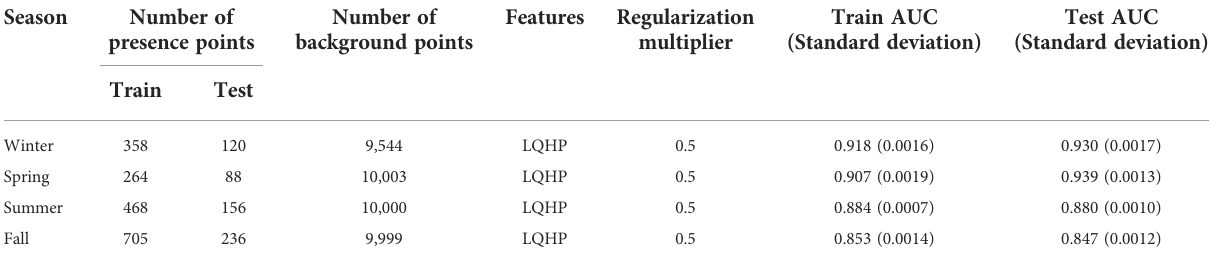
TABLE 3 Description and performance measures of the best MaxEnt.